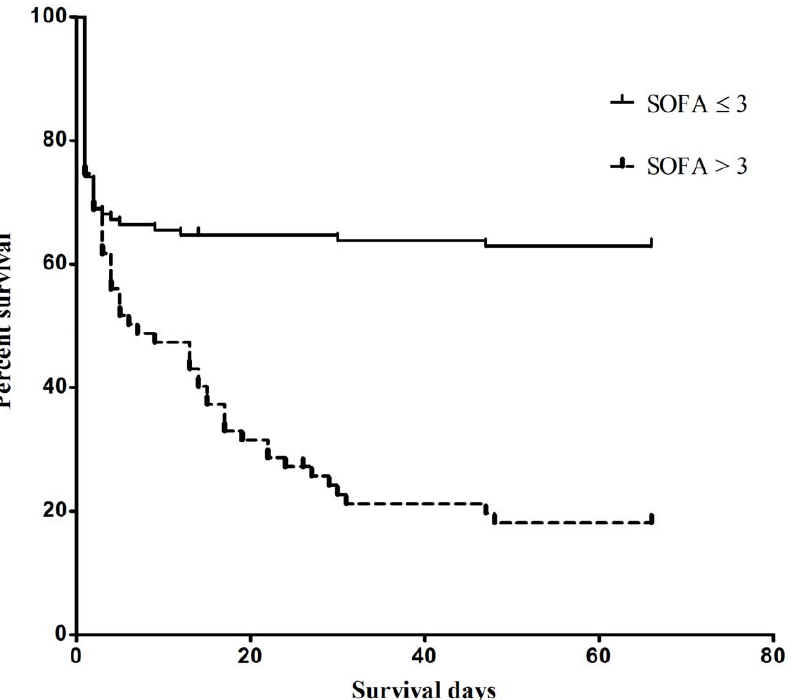
Figure 1. Cumulative survival rates based on SOFA 48-h score. Abbreviation. SOFA: sequential organ failure assessment. doi:10.1371/journal.pone.0051743.g001 PLOS ONE |